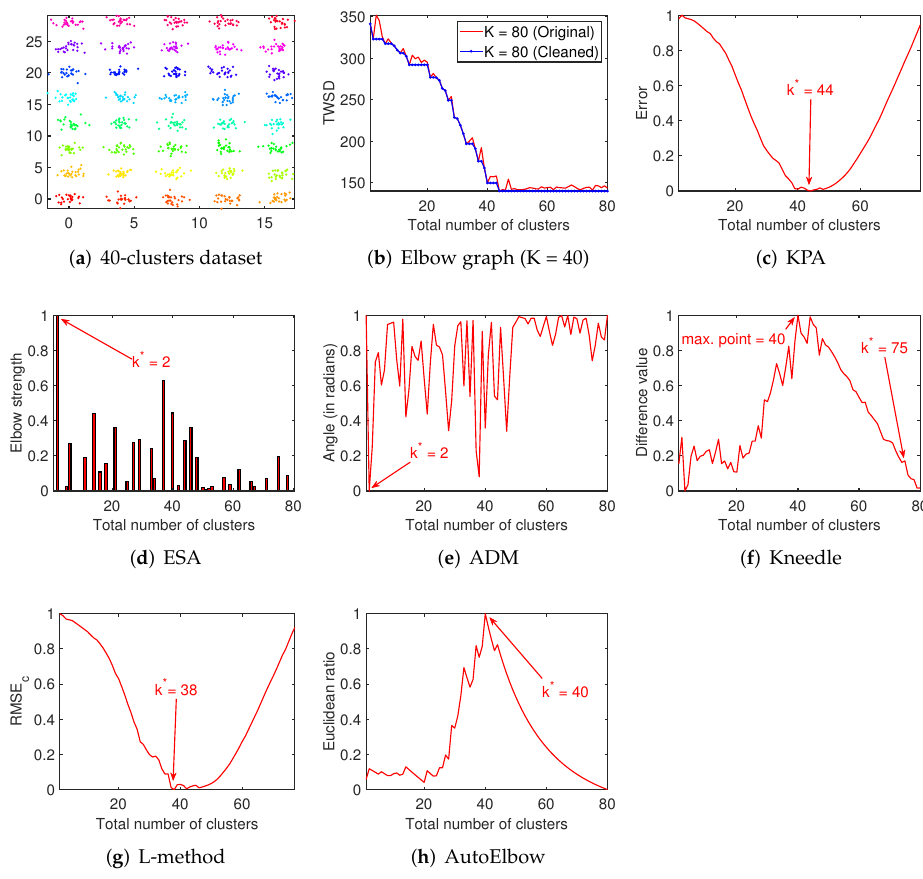
Figure 5. Large cluster number case study: 40